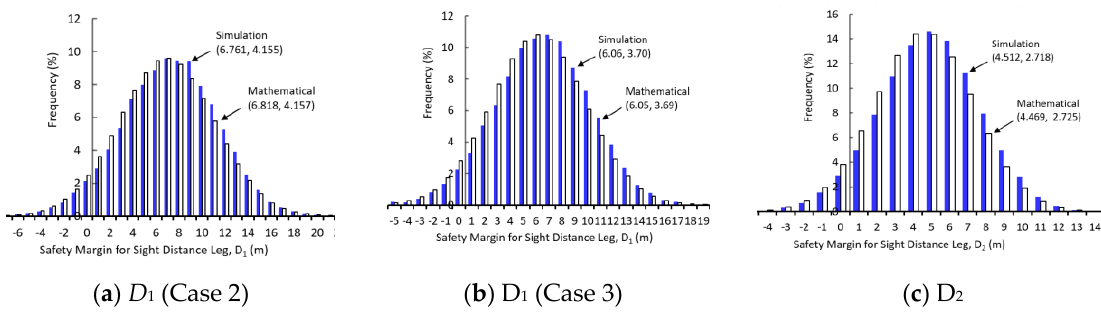
Figure 4. Comparison of the first-order second-moment method (FOSM) results of D 1 and D 2 by the analytical method and Monte Carlo simulation: ( a ) D 1 (Case 2, V e = 50 km/h, V c = 40 km), ( b ) D 1 (Case 3, V e = 50 km/h, V c = 30 km), and ( c ) D 2 ( V c = 30 km).